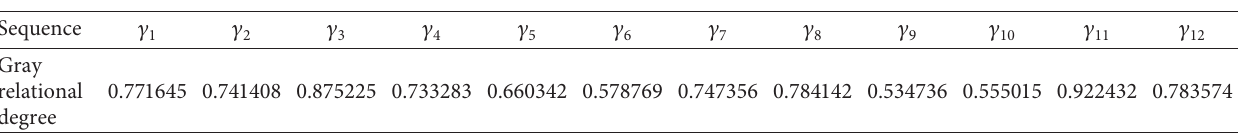
Table 6: Miners’ unsafe behavior for each sequence gray relational